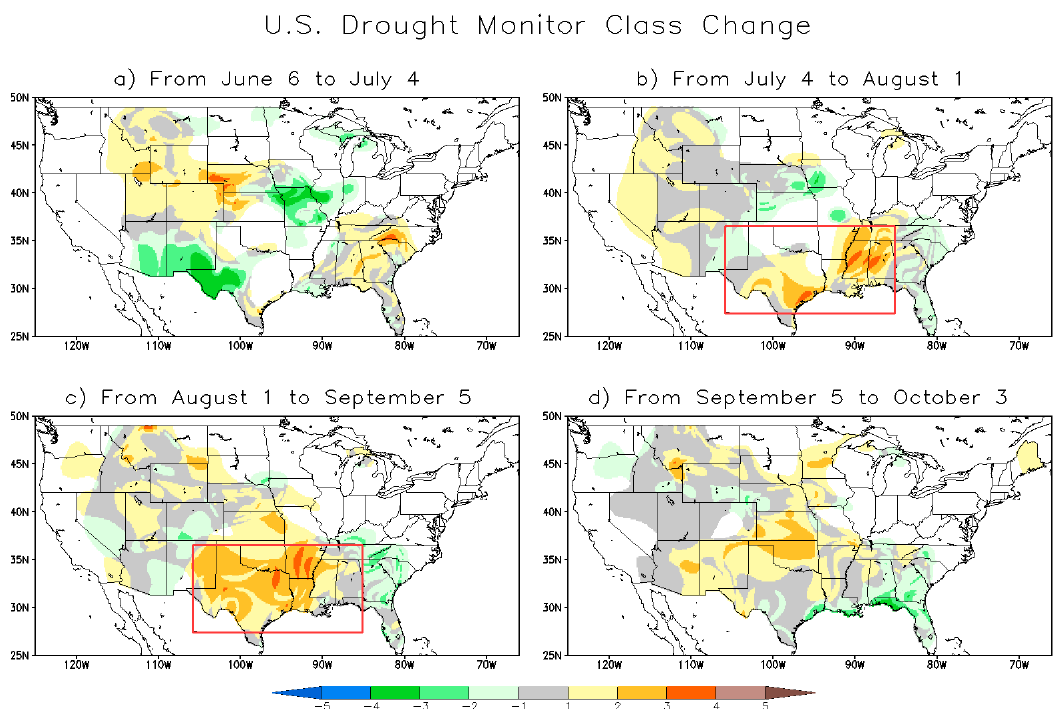
Figure 7. USDM change maps for the periods from June 6 to July 4 ( a ), July 4 to August 1 ( b ), August 1 to September 5 ( c ), and September 5 to October 3 ( d ) in Year 2000. Areas without drought are shown in white.